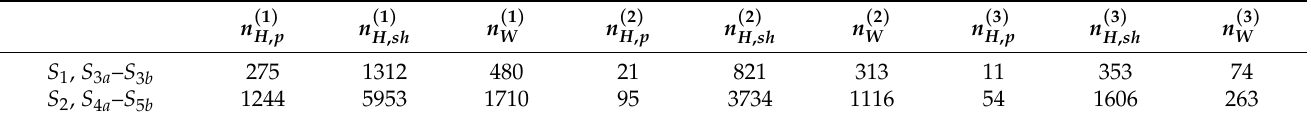
Table 4. Summary of charging events allocation in the FRB i networks. We list the maximum number of events allocated to a private home n scenario under